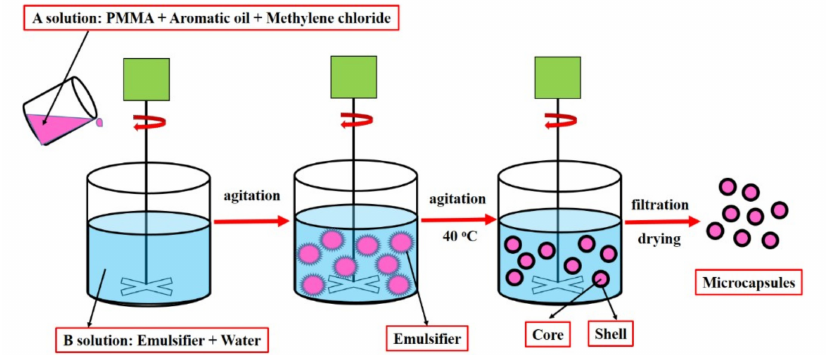
Figure 1. The schematic illustration of the sustained-release microcapsules preparation.